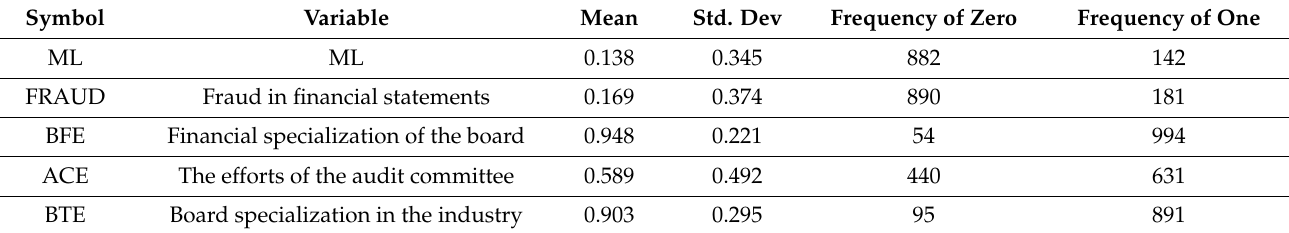
Table 4. The descriptive statistics of qualitative variables zero and one